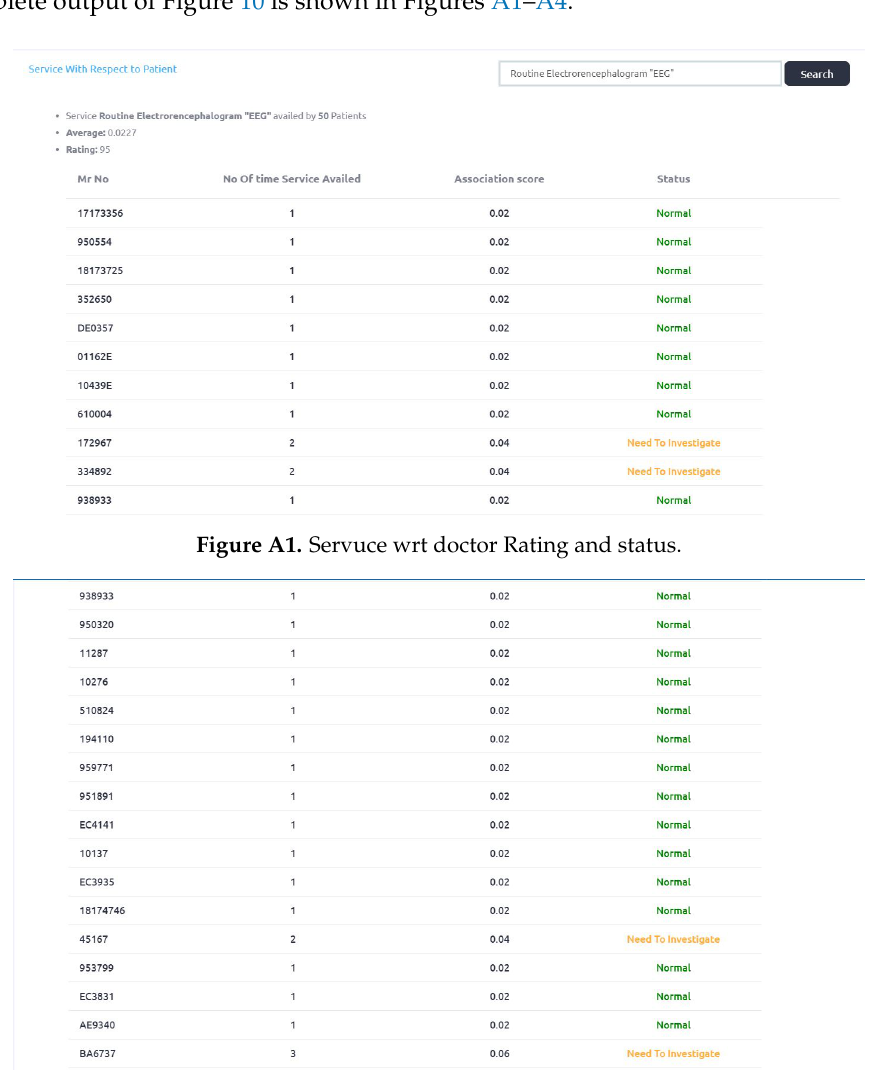
Figure A2. Servuce wrt doctor Rating and